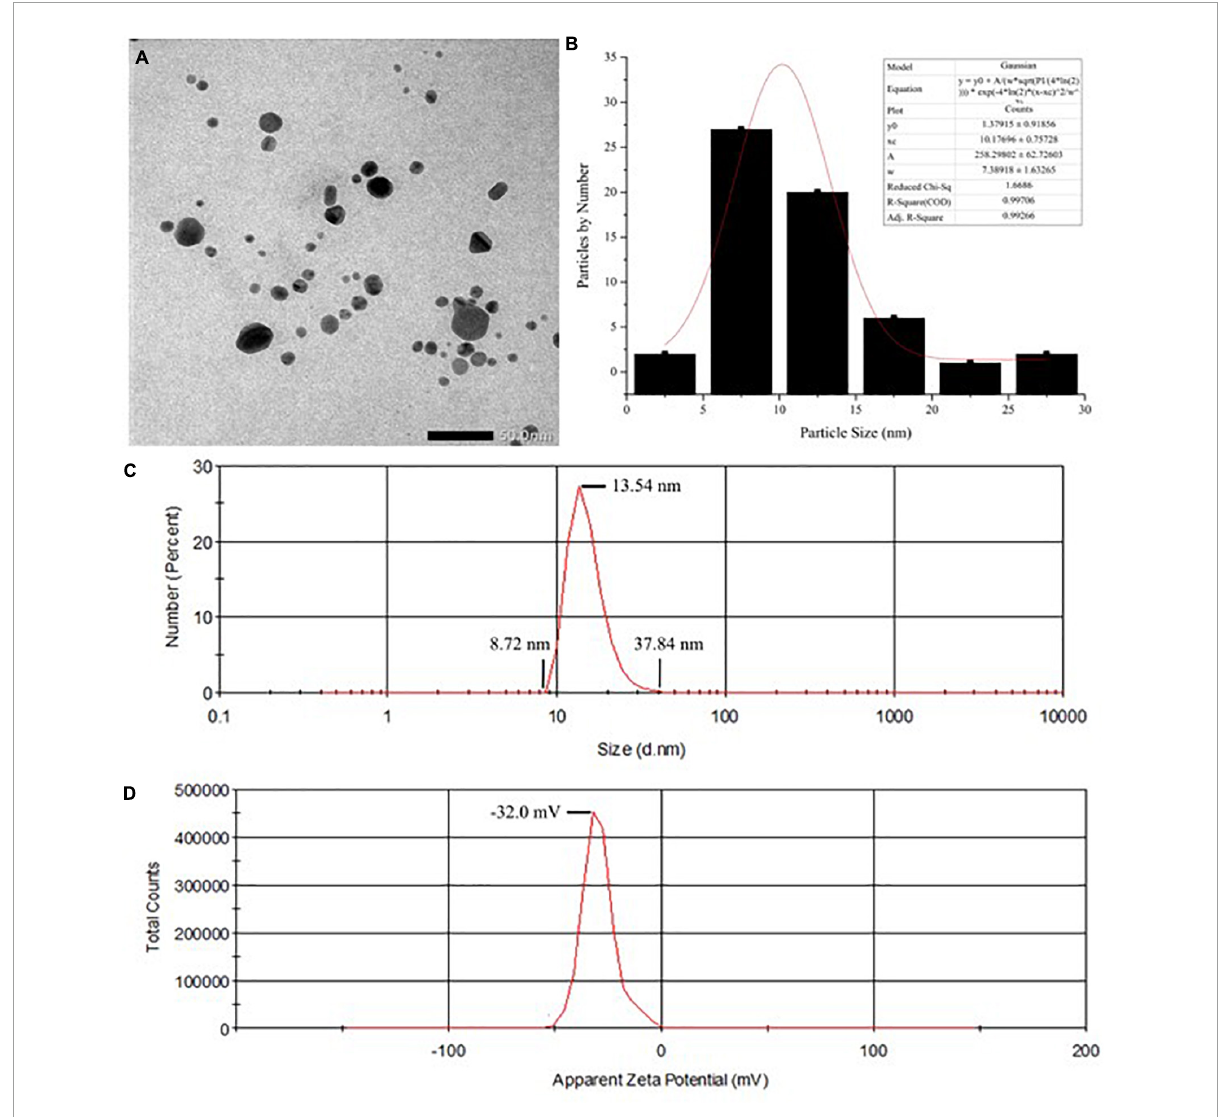
FIGURE3 (A) The TEM imaging and (B) particle size distribution of the AgNPs. (C) Hydrodynamic diameters and (D) zeta potential of colloidal AgNPs. TEM, transmission electron microscopy; AgNPs, silver